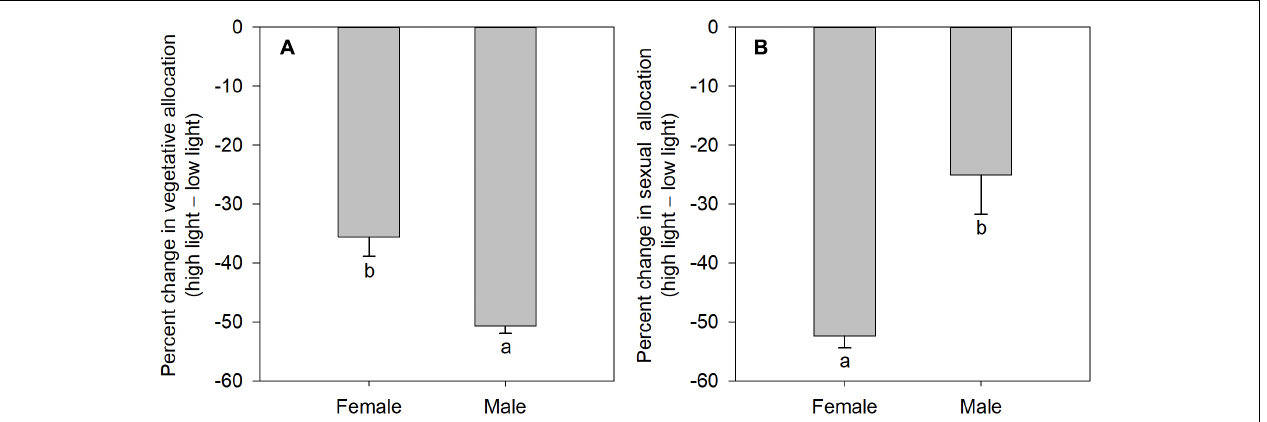
FIGURE 3 | The mean percentage change in vegetative and sexual reproductive tissues under low light regime relative to their average allocation under high light regime; values are means ± SE, for males and females of V. spinulosa . (A) Vegetative and (B) sexual reproductive allocations were calculated as percentage change in biomass of the respective tissues compared to the mean allocation to these tissues under high light regime for each sex. Values with different letters denote statistically significant differences between sexes ( P < 0.05), calculating using likelihood ratio